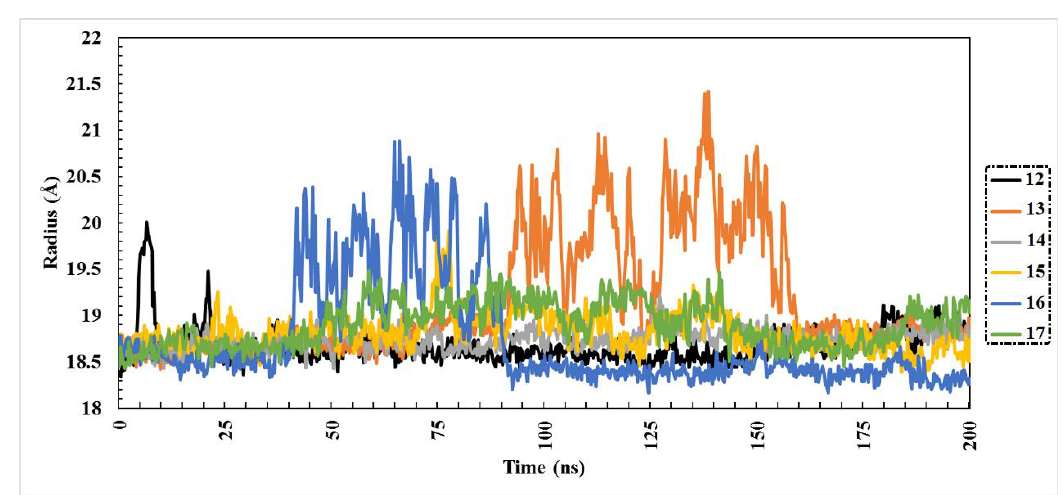
Figure 5. Radius of gyration (Rg) plot of six identified complexes through 200 ns MD simulations.